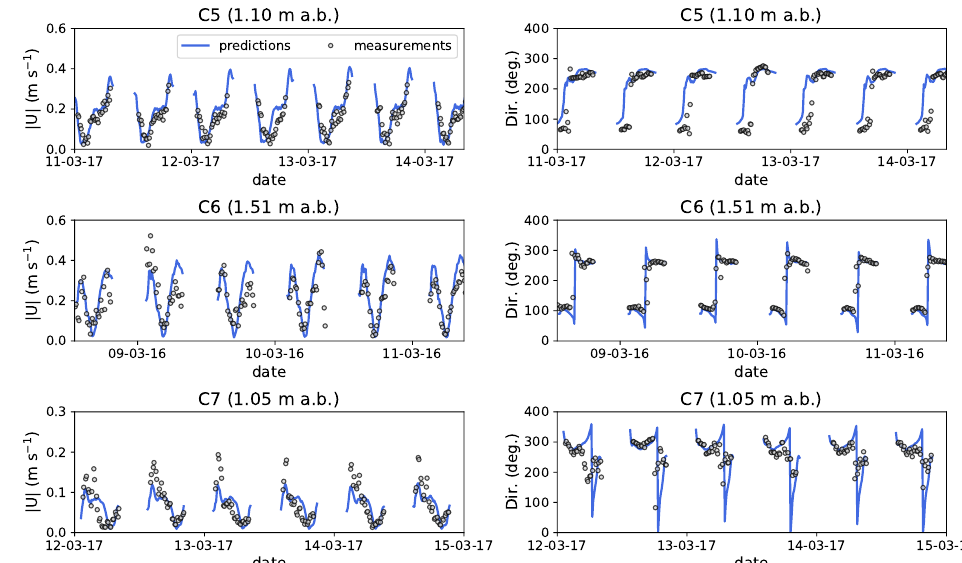
Figure 8. Time series of observed and predicted (in configuration E 3 ) tidal current magnitude and direction (anticlockwise convention from the East) in the eastern part of the estuary at points C5, C6, and C7 (a.b. for above the bed). Please note also that dates indicated correspond to midnight